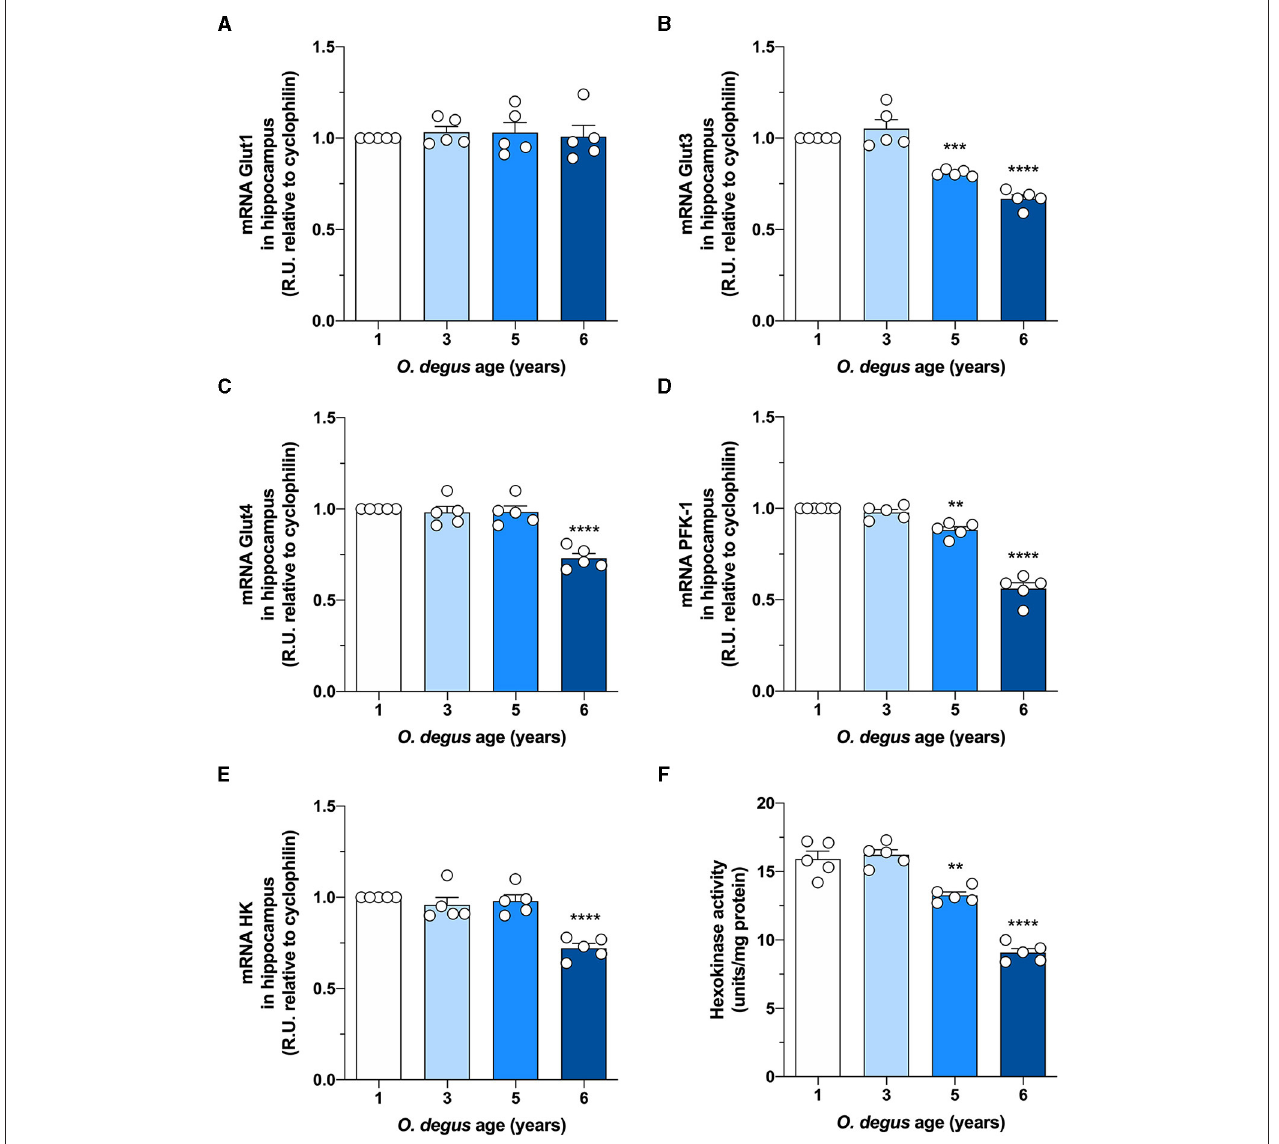
FIGURE 2 | Hippocampal expression of Glut3, Glut4, and glycolytic enzymes is decreased in aged degus. Quantitative RT-PCR of (A) Glut1, (B) Glut3, (C) Glut4, (D) phosphofructokinase-1 (PFK-1), and (E) hexokinase-1 (HK) expression in hippocampal lysates from 1- (control), 3-, 5-, and 6-year-old degus. (F) Hippocampal slices obtained from 1- to 6-year-old degus were used to assess the activity of HK by ELISA. The data represent the mean ± SEM of five independent biological replicates in three technical replicates. Statistical significance: ** p < 0.01, *** p < 0.001, and **** p < 0.0001 by one-way ANOVA, followed by Bonferroni’s post-hoc